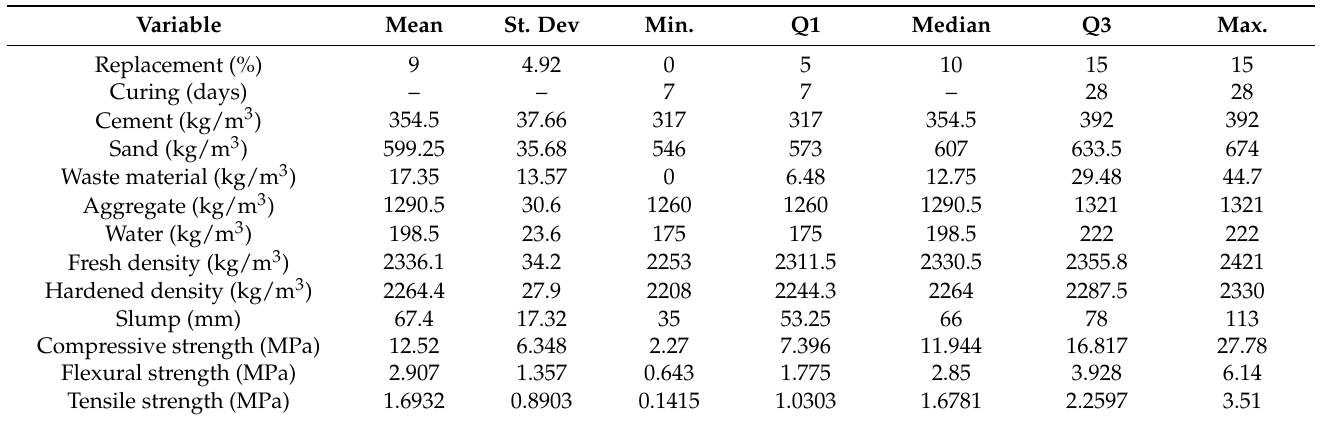
Table 4. Descriptive statistics data of eco-friendly rigid pavement green concrete.